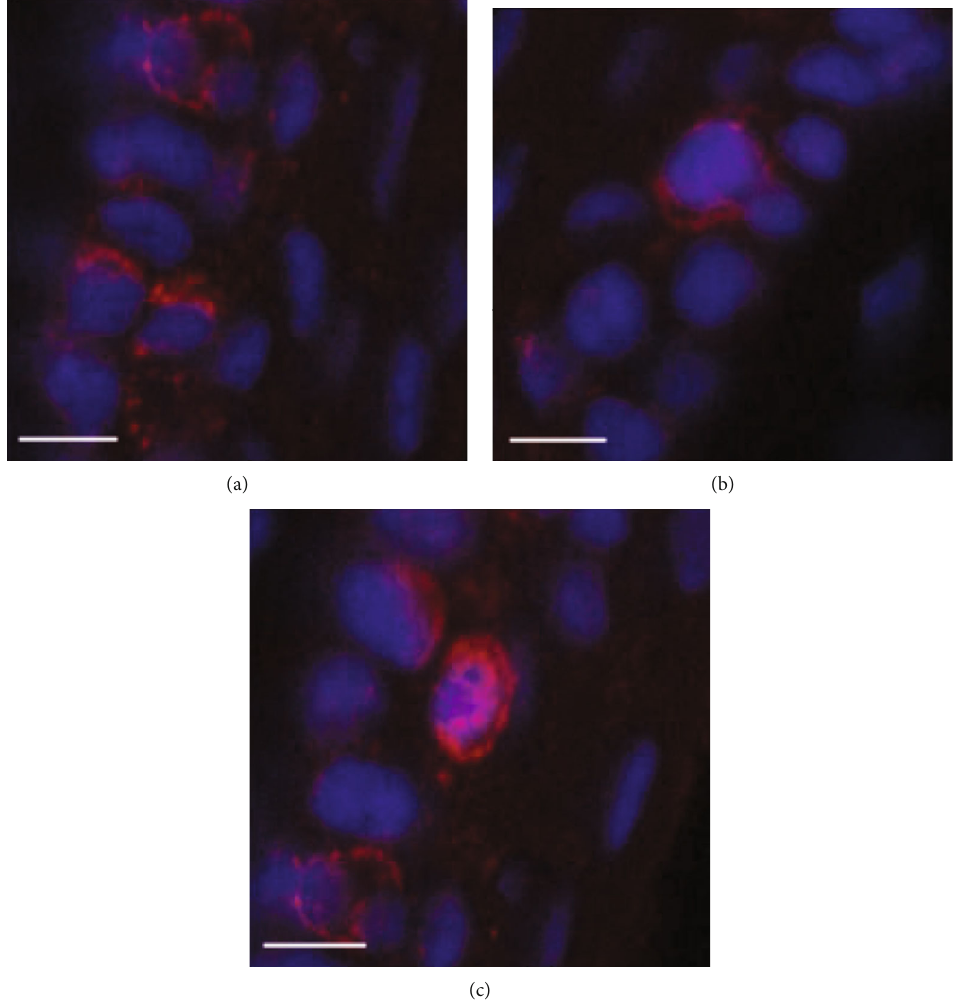
Figure 8: The result of immuno fl uorescence of LRR-1 in ICB. In the NC group, the positive expression of LRR-1 was clearly visible (a). In the EIU group, the positive expression of LRR-1 was occasionally observed (b). In the ET group, the positive expression of LRR-1 was higher than that in the EIU group, but still slightly lower than that in the NC group. Scale bars: 50 μ